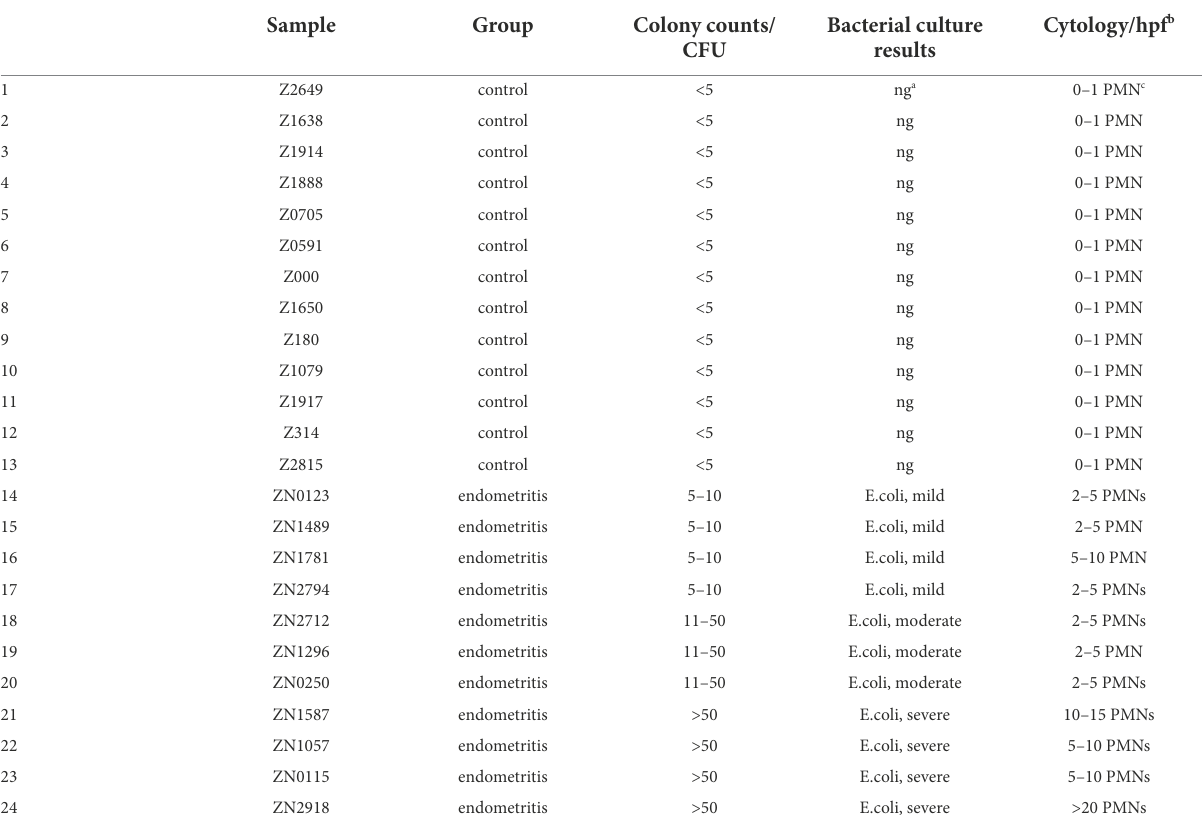
TABLE 1 Bacterial culture and cytology results from uterine swab samples from 22 donkey